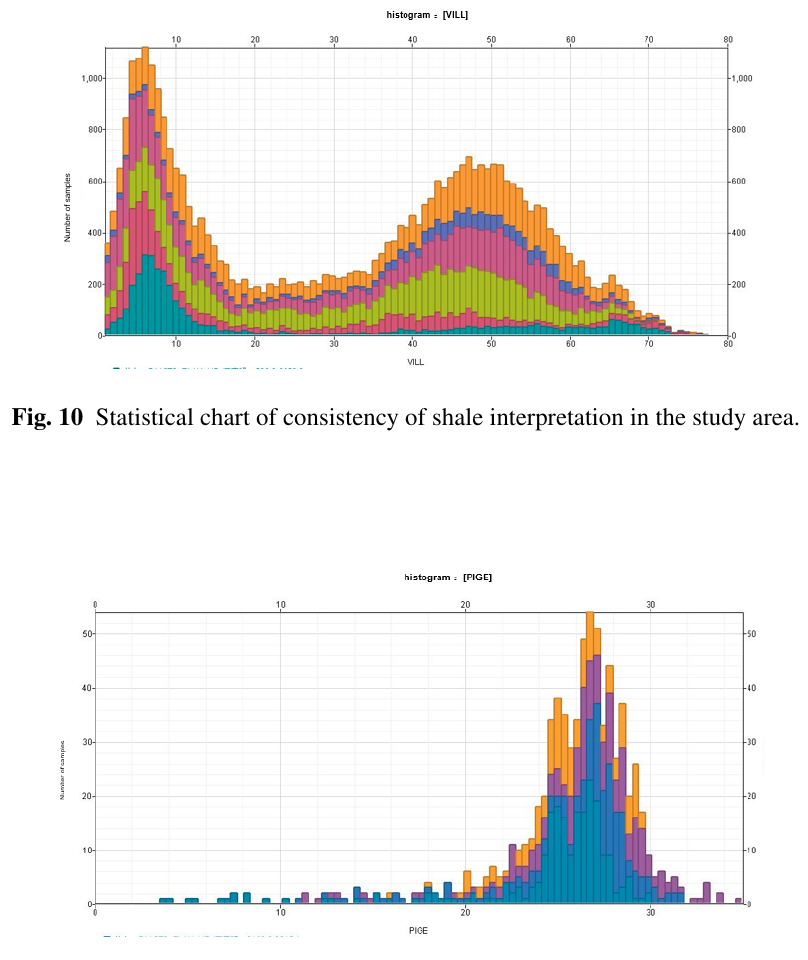
Fig. 11 Consistency analysis of porosity interpretation in the study